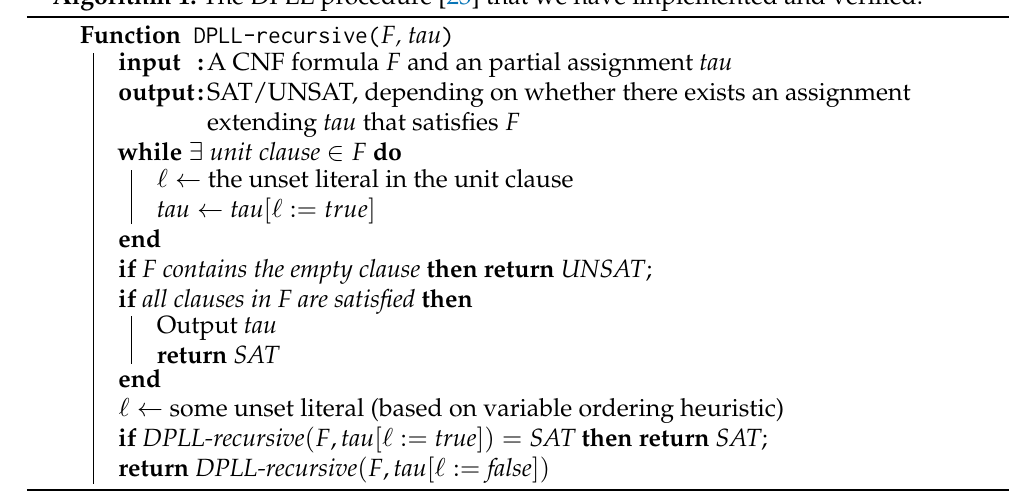
Algorithm 1: The DPLL procedure [23] that we have implemented and verified. Function DPLL-recursive( F, tau